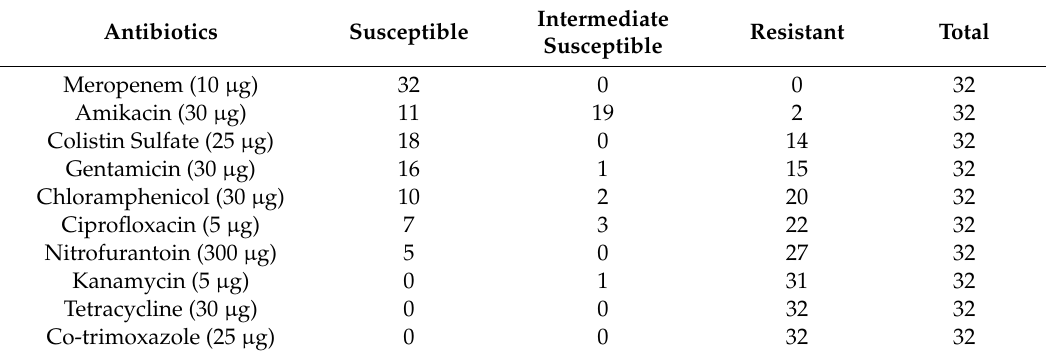
Table 5. Overall antibiogram of all the ESBL-PE isolates.